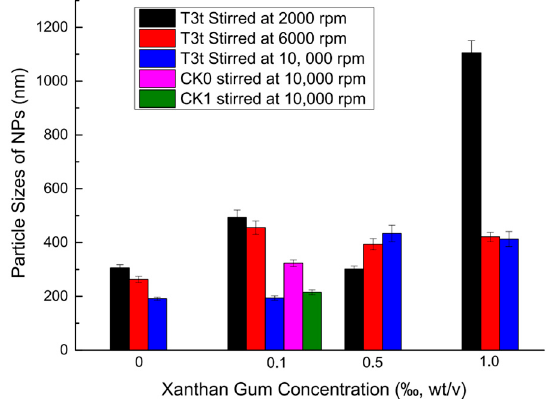
Figure 5. Particle sizes and zeta potentials of AZO-loaded NPs prepared with ionic emulsifiers. 2.4. Thermo-Responsive AZO-Loaded NPs Underwent Morphological Transformations at 30 °C and Original AZO Crystals Were Recovered after Drying The thermo-responsive behaviors and crystal characteristics of T3T-13 and T3T-c12 under SEM observation are shown in Figure 6 and Figure 7, respectively. When there was no TDA in the nanosystems, the particle morphology stayed the same whether they were desiccated at 20 °C or 30 °C (Figure 6: CK0-20, CK0-30). For the TDA-containing samples, an obvious transformation in NPs appearance from regular to irregular spheres was ob- served when the desiccating temperature increased from 20 °C to 30 °C. The coverage area of the T3t-c12-30 NPs increased when compared with that of the T3t-c12-20 NPs; the pos- itively charged surface may have driven their dispersal on the negatively charged silicon surface. Though T3T-13 and T3T-c12 showed different thermo-responsive behaviors, the reappearance of the typical AZO diffraction angle around 11° on dry T3T-13 and T3T-c12 NPs (Figure 7: T3T-13-NPs and T3T-c12-NPs) indicated that both recovered their original AZO crystal structures after the NPs were desiccated; this should benefit the original sys- temic activity of AZO.